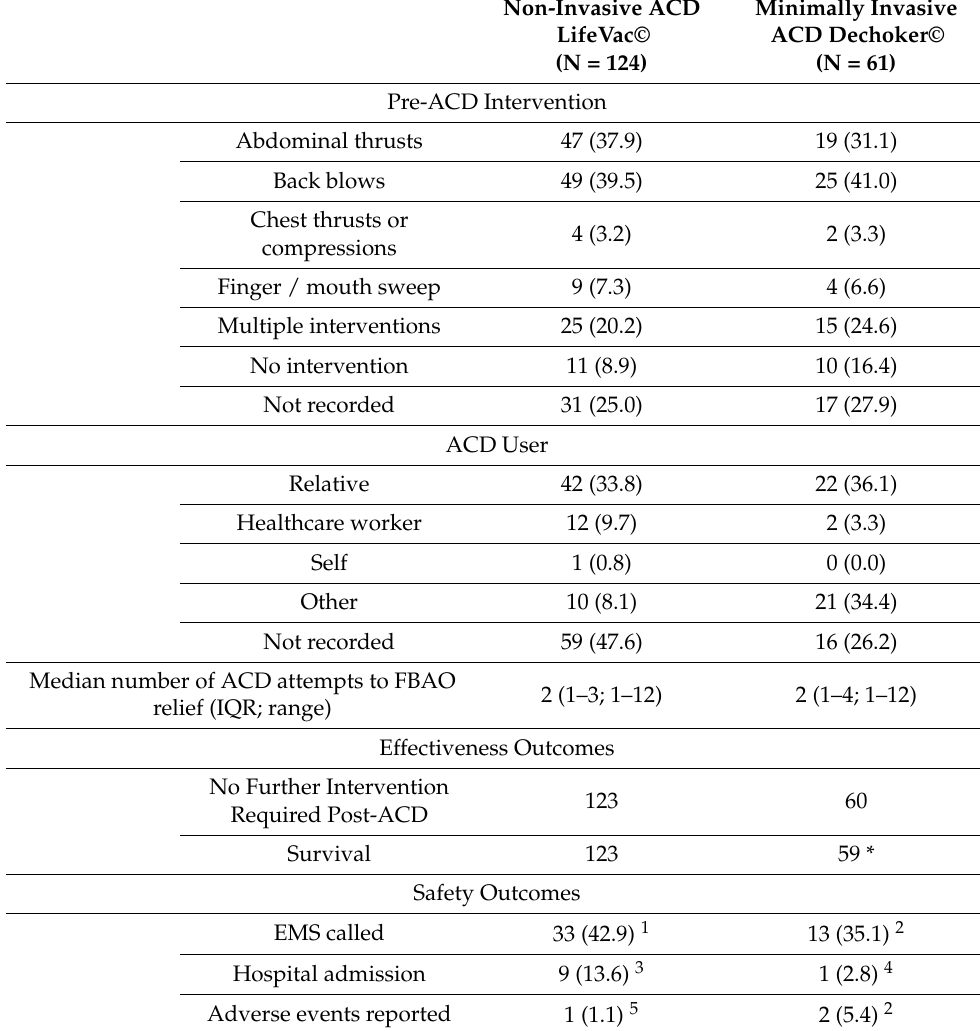
Table 3. Intervention and outcome data for patients with a FBAO intervened by an airway clearance